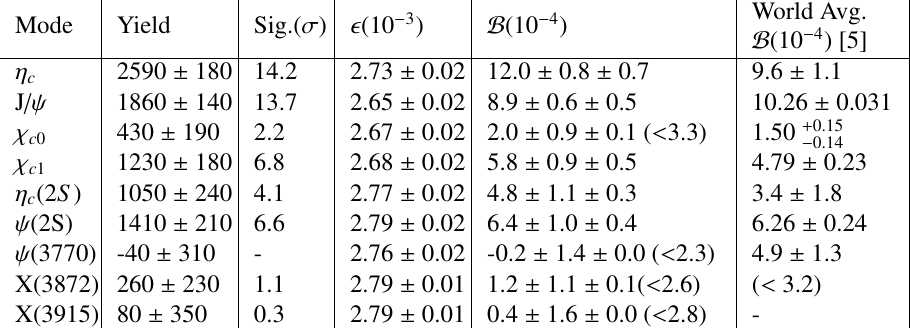
Table 1: Summary of the branching fraction measurements for B + → X c ¯ c K +